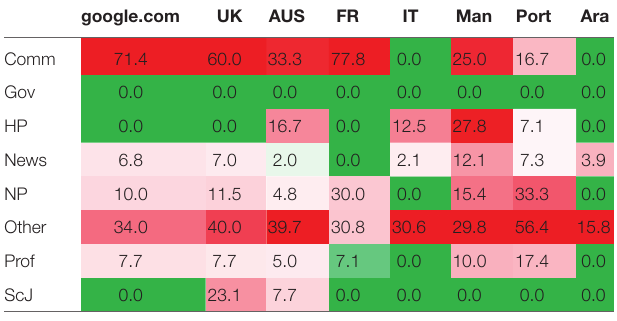
average vaccine-negative in the total search engine result page (serP) 16.6 Data indicate the percentage of vaccine-negative webpages in each typology. Cells are color coded to show difference from “expected” based on the frequency in the total SERP shown in the bottom row (red, above the expected frequency; green, below the expected